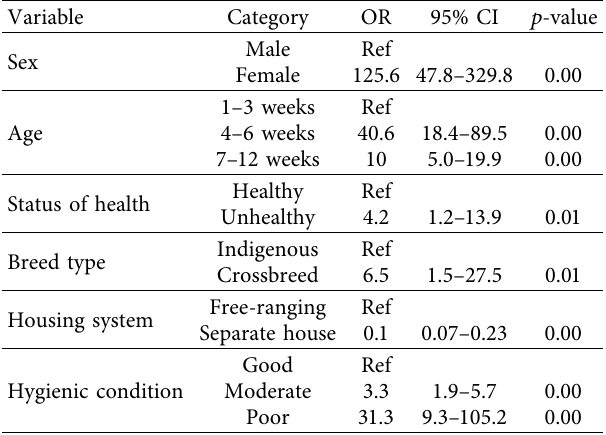
Here, a p value ≤ 0.05 was considered statistically significant, CI � confidence interval. Table 4: Multivariable logistic regression model between binary response variable results and the selected factors ( N �